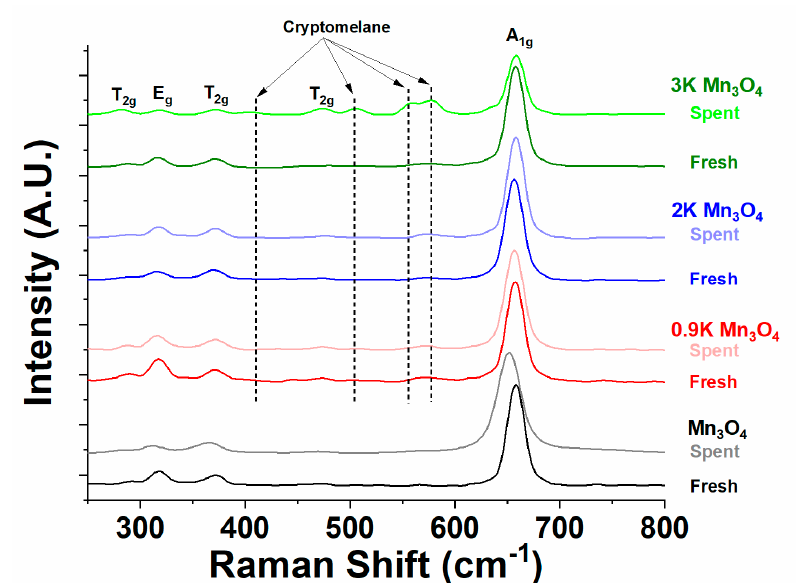
Figure 10. Raman spectra of fresh and spent Mn 3 O 4 catalysts with varying K loading. The A 1g , E g , and three T 2g bands of Mn 3 O 4 are labeled for reference. Drop lines are extended to emphasize the Raman bands attributed to the presence of cryptomelane (KMn 8 O 16 ) for samples containing K.